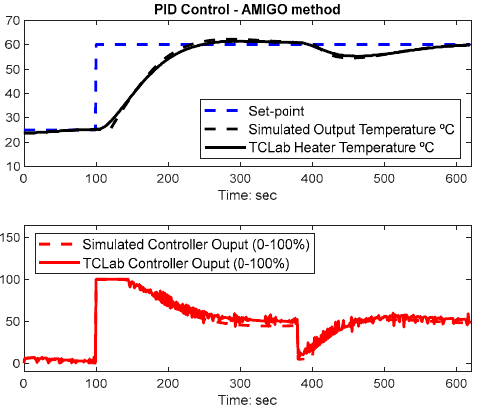
Figure 12. Simulated and TCLab responses using AMIGO settings.